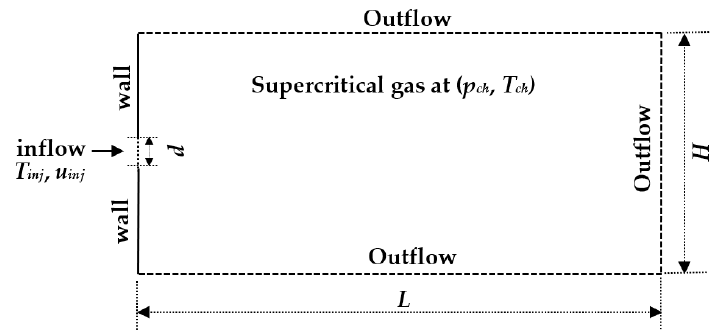
Figure 3. Two-dimensional computational domain with boundary conditions .